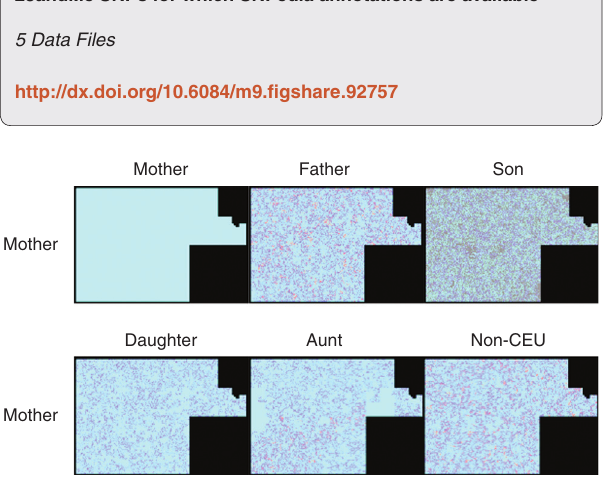
Figure 5. A graphical representation of the SNPs from chromosome 1 for Mother compared with herself, Father, Son, Sister, Aunt and non-CEU. Each pixel represents a SNP. Light blue represents match, dark blue half-match and red conflict. SNPs in Son that are not present in the genotypes of the other individuals are represented in grey.